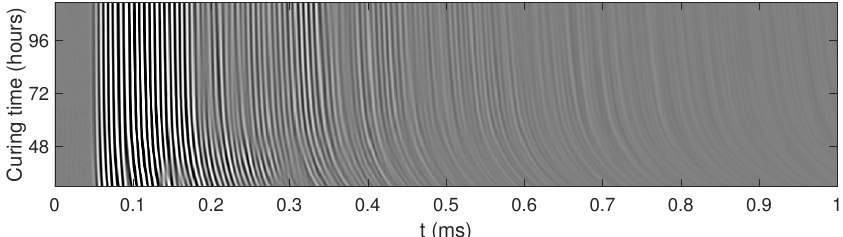
Figure 4. Stacked ultrasonic signal image shows the trend of time shifts in early-age concrete. Figure 5 gives the calculated relative wave-velocity change between signals recorded at ages of 75th hour and 80th hour. A moving time window with a width of 0.1 ms and a step of 0.05 ms is used for stretching analysis. It can be seen that different time windows give the same dV / V results. The cross-correlation coefficient CC ( ε max ) calculated at each moving time window is above 0.99, which indicates a very weak distortion between these two signals.